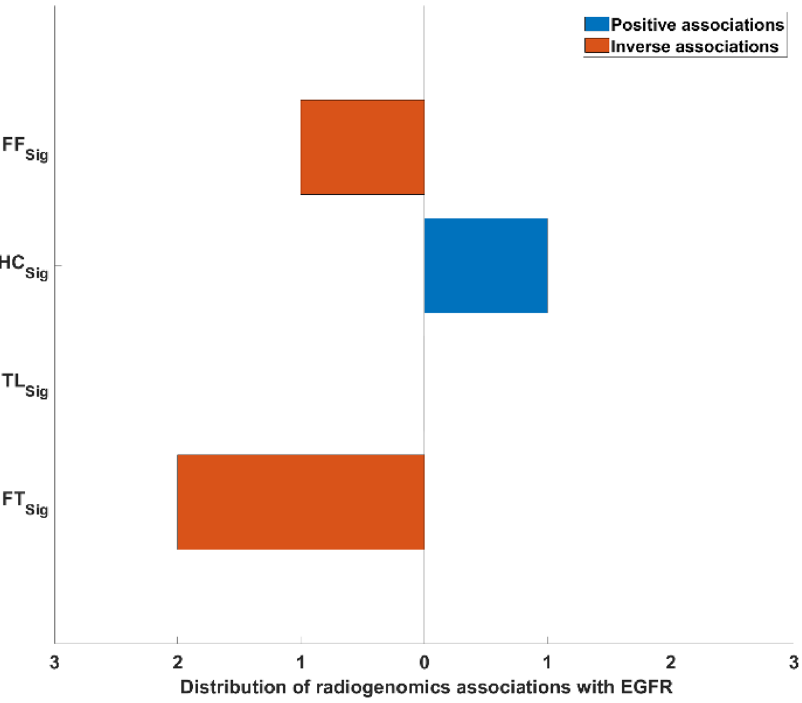
Figure 5. The distribution of RRs between the FF Sig with the key genetic biomarker of EGFR from the NRG-H dataset, in comparison to HC Sig , TL Sig and FT Sig .